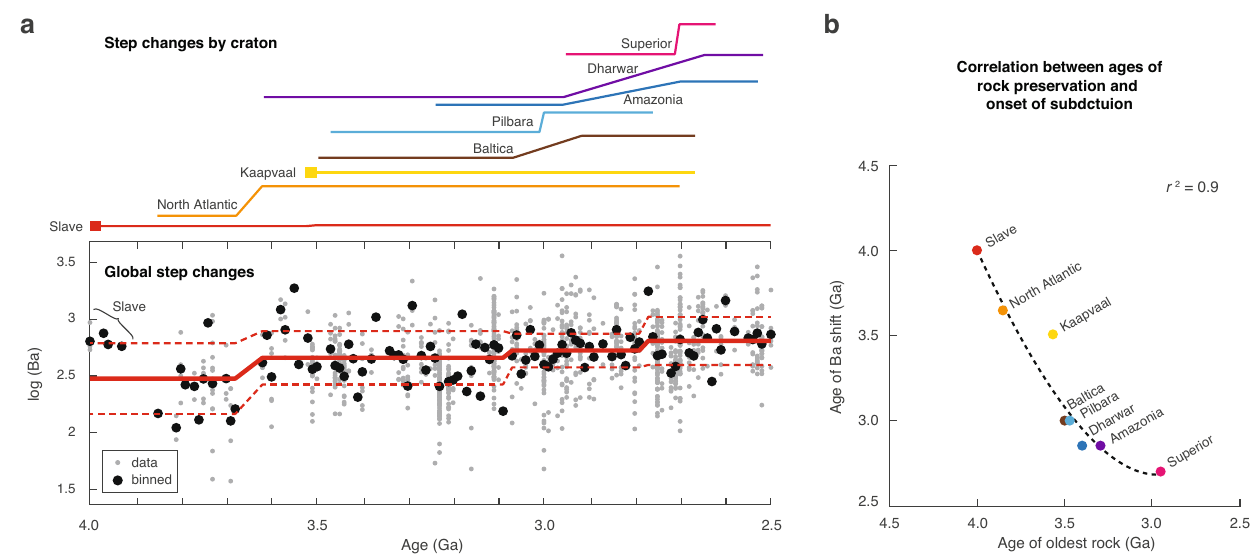
Fig. 4 | Ba content of Archaean tonalite – trondhjemite – granodiorite (TTG) suites.a BacontentsofTTGsuites throughthe Archaean.The grayand blacksolid circles represent the real and binned compositions of natural TTG suites,